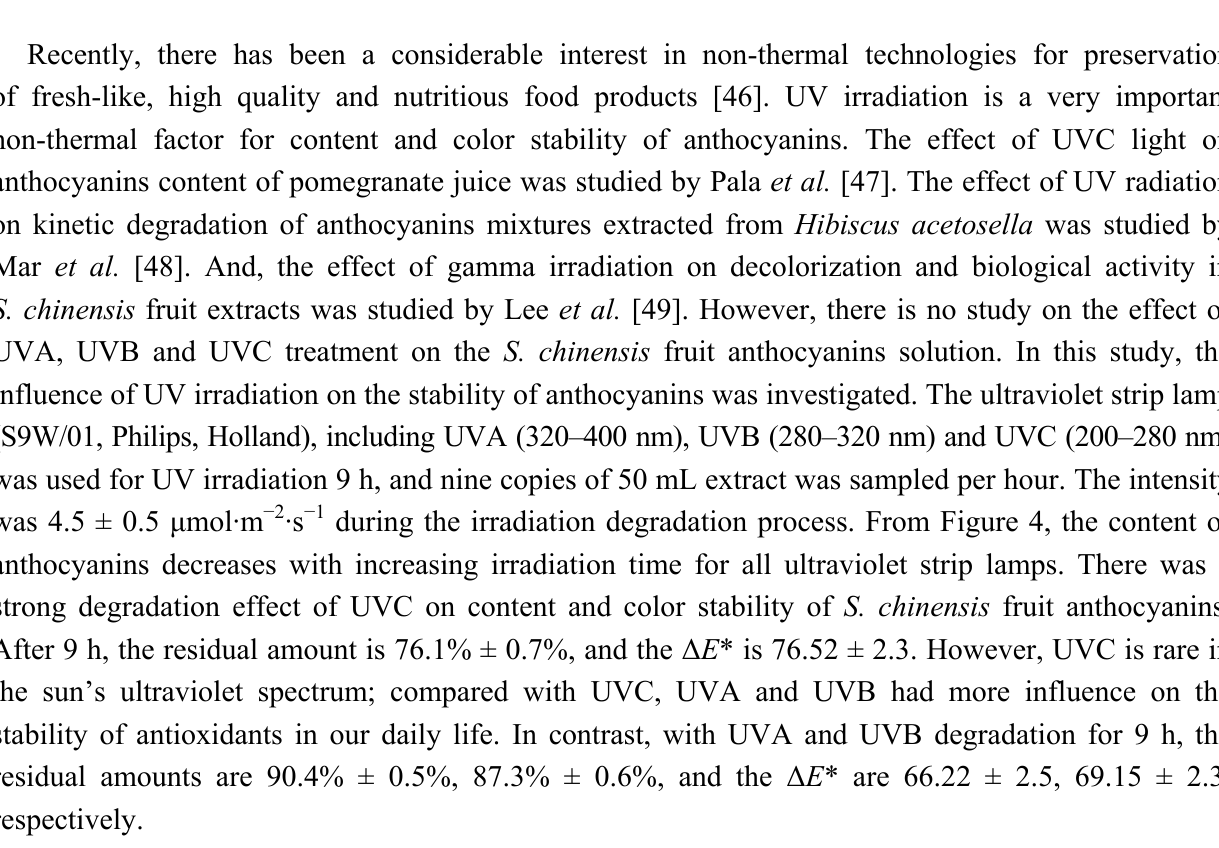
Figure 4. Effect of ultraviolet irradiation on content ( a ) and color ( b ) stability of S. chinensis fruit